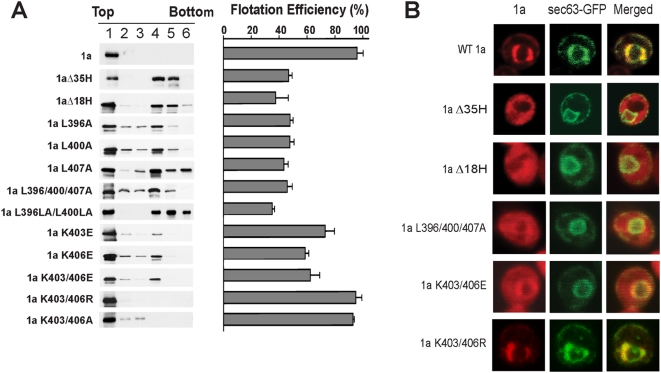
Helix A and specific non-polar (L) and polar residues (K) in it are required for efficient 1a membrane binding and ER targeting.(A) Distribution of wt 1a or 1a helix A mutants in membrane flotation gradients. Representative western blots using anti-1a antiserum are shown on the left, the histogram on the right shows average flotation efficiencies based on three independent experiments, calculated as in Figure 1. The levels of commonly observed less-than-full-length 1a-derived degradation products (whose separation from 1a depends on the particular gel composition and run time used) were not included in the calculations. (B) Fluorescence microscopy images of cells expressing wt 1a or 1a helix mutants and Sec63-GFP as an ER marker.